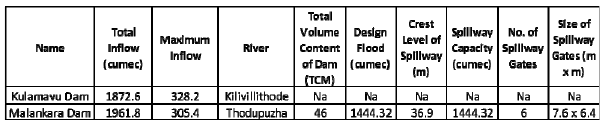
The maximum inflow obtained by watershed based simulation at Kulamavu and Malankara dams were 328 and 305 cumec respectively. The maximum discharge at the outlet was